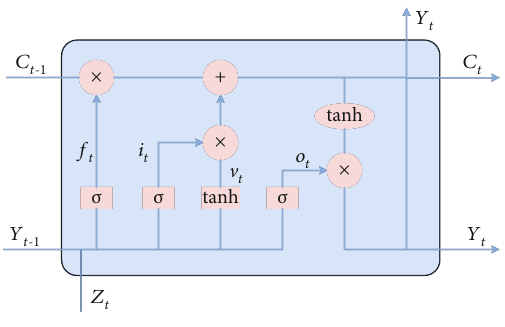
Figure 2: LSTM model structure